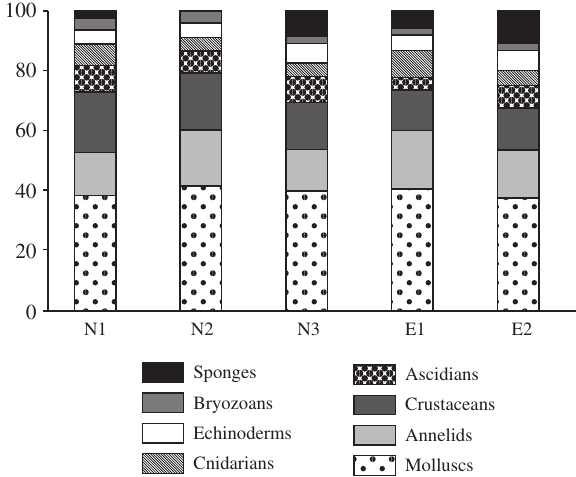
Fig . 2. – Bar plot of cumulated percentages of species for each phy- lum, which was found associated with the five populations of Pinna . Localities are shown in fig.